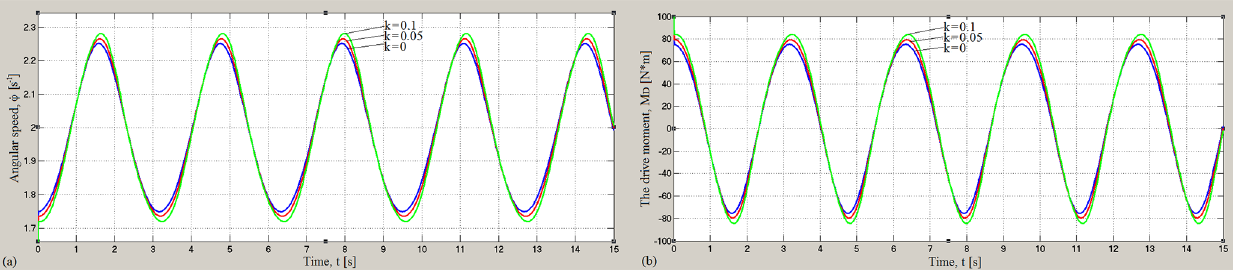
Figure 11. Dependencies of angular velocity (a) and engine torque (b) on the time at different values of the coefficient of rotational friction k and for value of the coefficient of sliding friction f = 0.